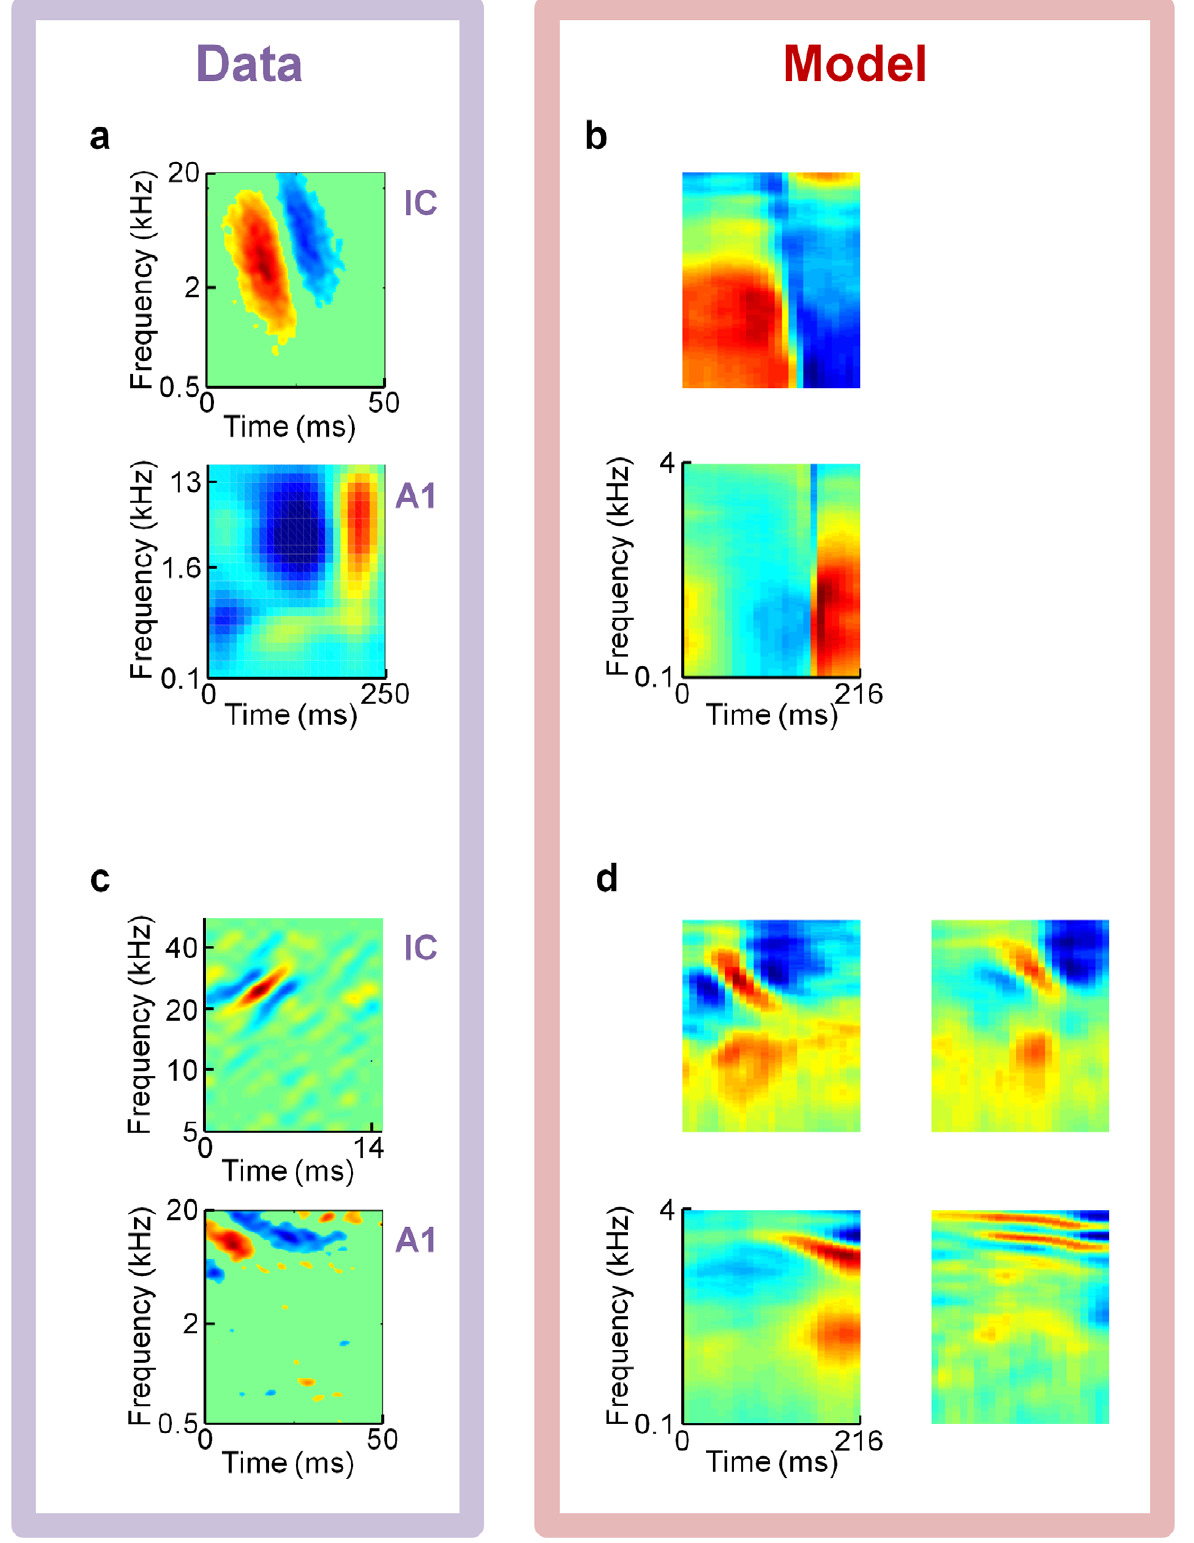
Figure 8. Model comparisons to receptive fields from auditory midbrain and cortex. on spectrograms of speech predicts several classes of broadband spectro-temporal receptive field (STRF) shapes found in Inferior Colliculus (IC) and primary auditory cortex (A1). ( a,b ) An example broadband OFF-type STRF from cat IC [34] (top; data courtesy of M.A. Escabı´) and an example broadband ON-type subthreshold STRF from rat A1 [35] (bottom; data courtesy of M. Wehr) shown in panel a resemble example elements from a four-times overcomplete, L0-sparse, spectrogram-trained